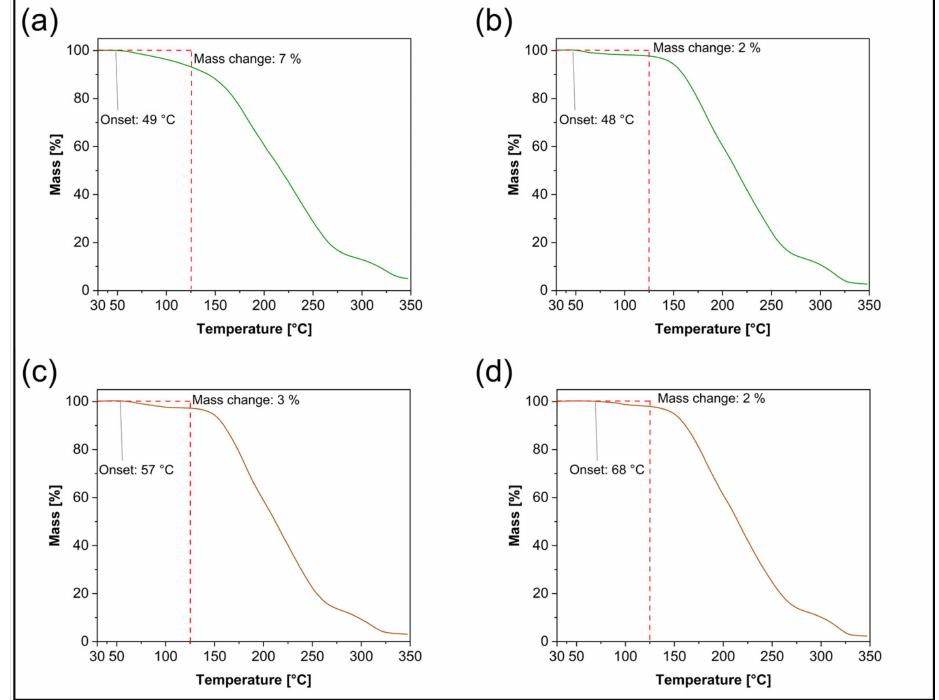
Figure 11. Thermogravimetric analyses of 3 -based maleates recorded after two weeks of drying at ambient conditions. A solvent sample ( a ) and a mechanochemically prepared sample ( b ) of ( S )-3-MA • H 2 O , a solvent sample ( c ) and a mechanochemically prepared sample ( d ) of ( rac )-3-MA . Decomposition was recorded in a range of 30 ◦ C–350 ◦ C. The red dotted line indicates the mass loss at 125 ◦